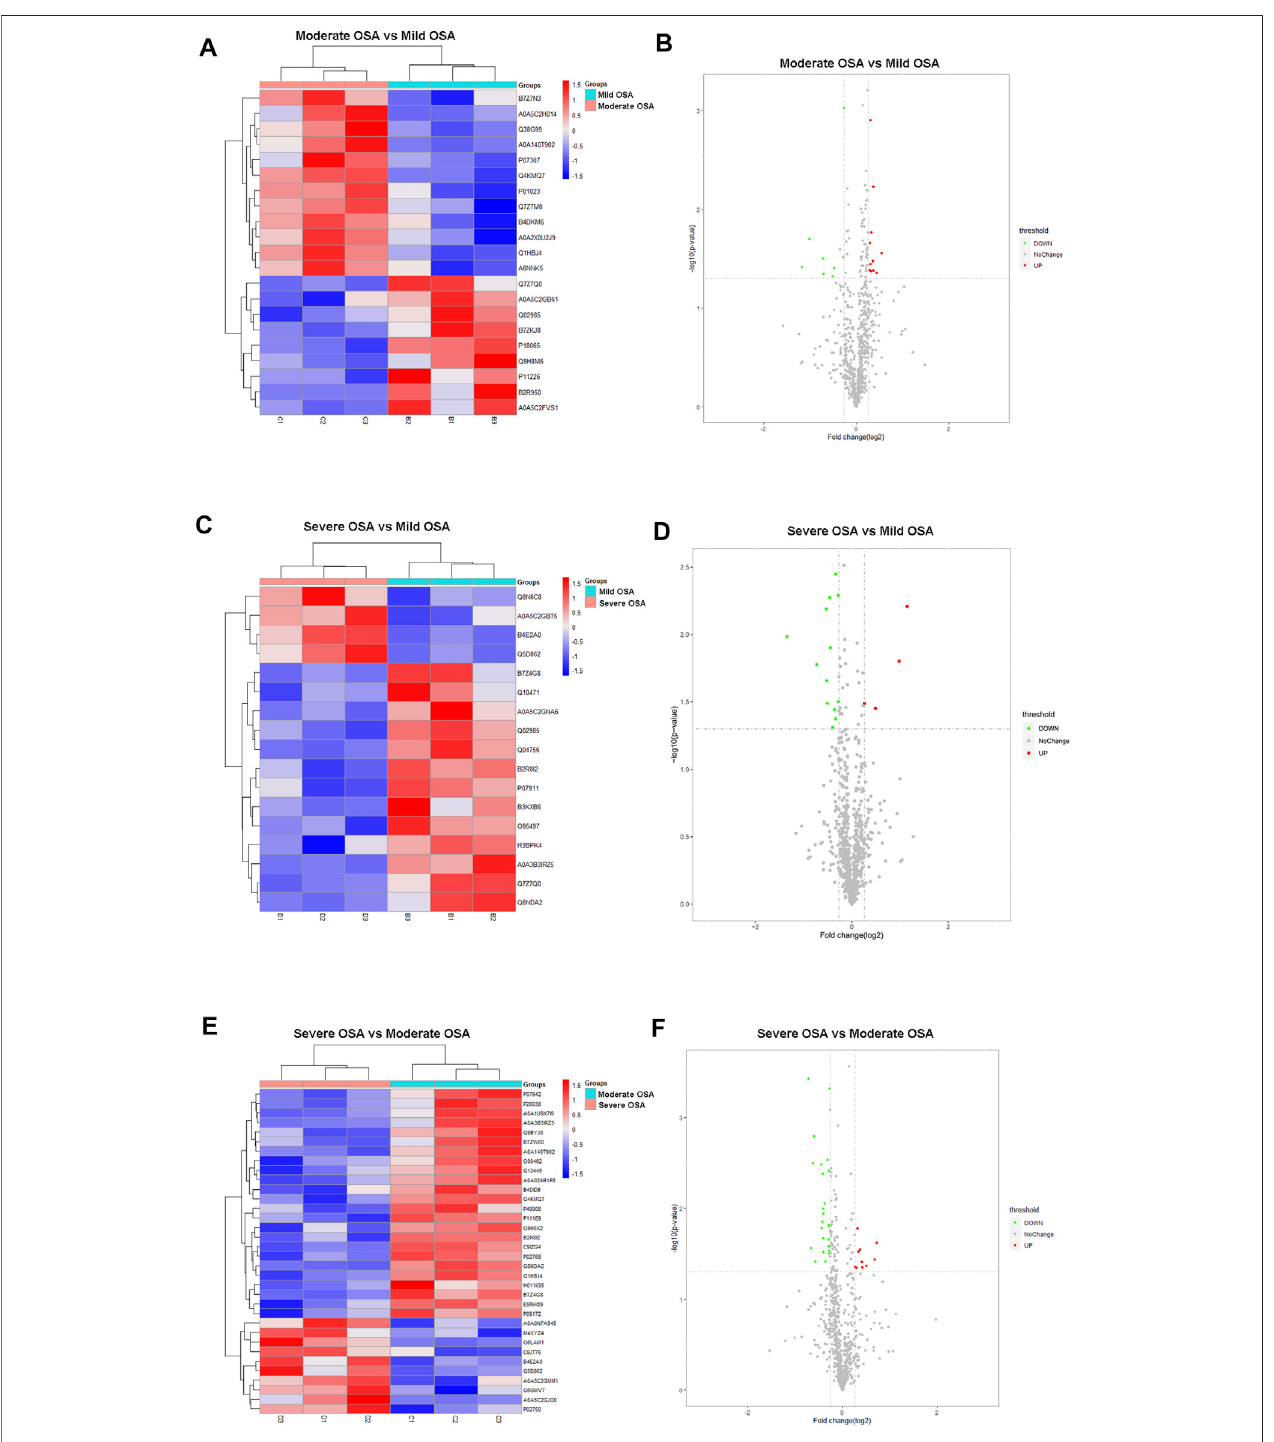
FIGURE4| Hierarchicalclusteranalysisandvolcanoplots: (A) hierarchicalclusteranalysisand (B) volcanoplotanalysisofdifferentiallyexpressedproteinsbetween themoderateOSAgroupandmildOSAgroup, (C) hierarchical clusteranalysisand (D) volcanoplotanalysisofdifferentiallyexpressed proteinsbetweenthesevereOSA group and mild OSA group, (E) hierarchical cluster analysis and (F) volcano plot analysis of differentially expressed proteins between the severe OSA group and moderate OSA group C.